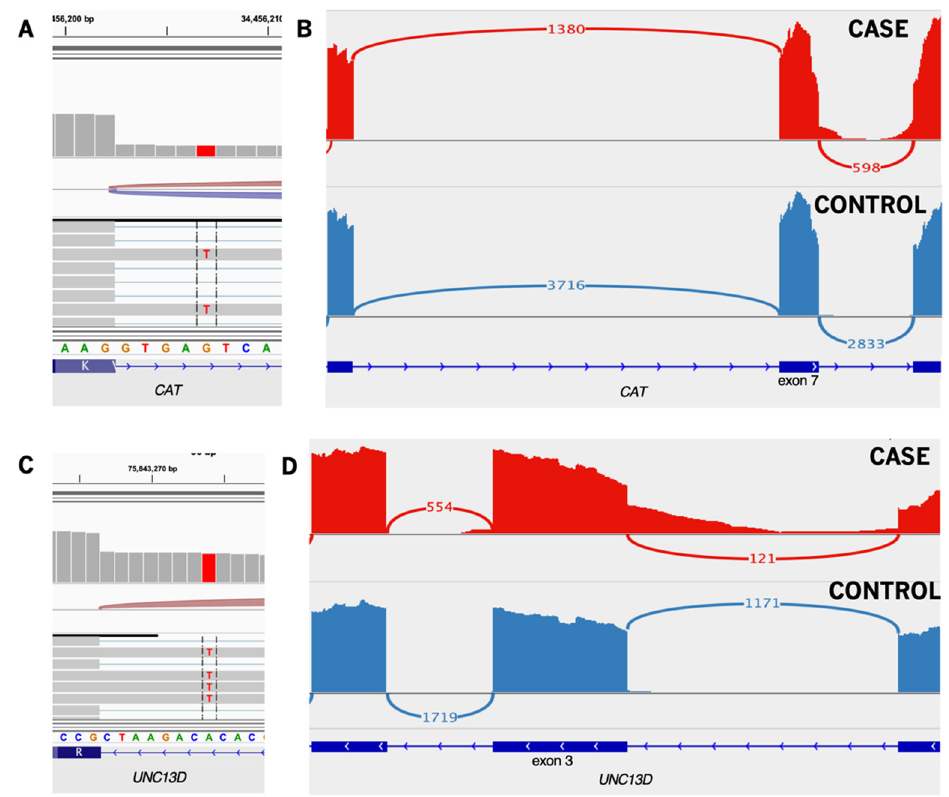
Figure 5. Intron retention events in CHB953. ( A ) The extended splice variant in CAT is present in all unspliced reads. ( B ) Unspliced reads are visible in the CAT intron. Normalized spliced read counts from this exon are around 60% of what is seen in other samples. ( C ) The extended splice variant in UNC13D is present in all unspliced reads. ( D ) Unspliced reads are visible in the UNC13D intron. Normalized splice read counts from this exon are around 40% of what is seen in other samples. Irregular coverage of retained intron reads is due to decay with distance from the pulled-down exon. Sashimi plots show only the affected and immediately adjacent